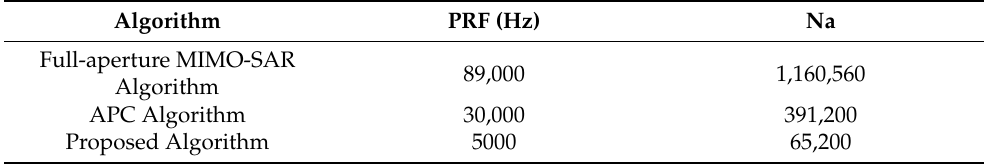
Table 4. Number of azimuth sampling points and pulse repetition rate (PRF) of different algorithms.